Question: Provide a one-line summary of what is displayed.
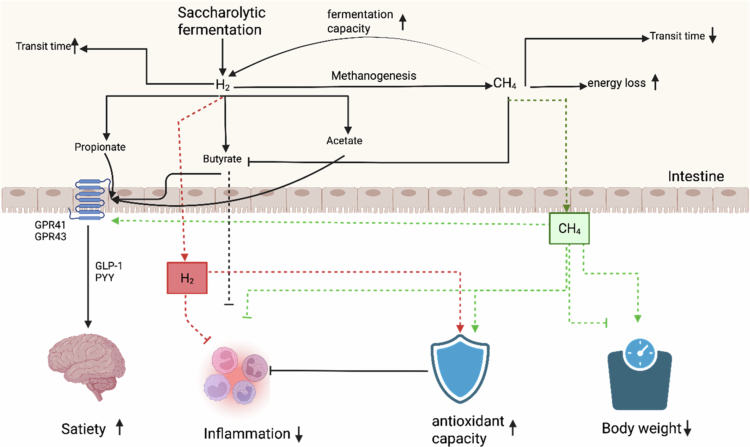
Answer: Interplay between H 2 and CH 4 production and their impact on host metabolic pathways. The black arrows indicate direct colonic-mediated effects from intestinal gases, the red lines indicate direct effects of H 2, and the green arrows indicate direct effects of CH 4 on host physiology. H 2 is derived from saccharolytic fermentation and converted into SCFA and CH 4 . The conversion of H 2 to CH 4 causes energy loss and reduces partial pressure, allowing fermentation to continue and shifting fermentation from butyrate to acetate. SCFA can affect satiety through GPR activation. In the colon, H 2 decreases the transit time, whereas CH 4 increases the transit time. H 2 and CH 4 may also directly beneficially affect the host by improving satiety, inflammation, antioxidant capacity and body weight through direct and indirect mechanisms. H2; hydrogen, CH4; methane, GPR; G protein-coupled receptors, GLP-1; glucagon-like peptide-1; PYY, protein YY.